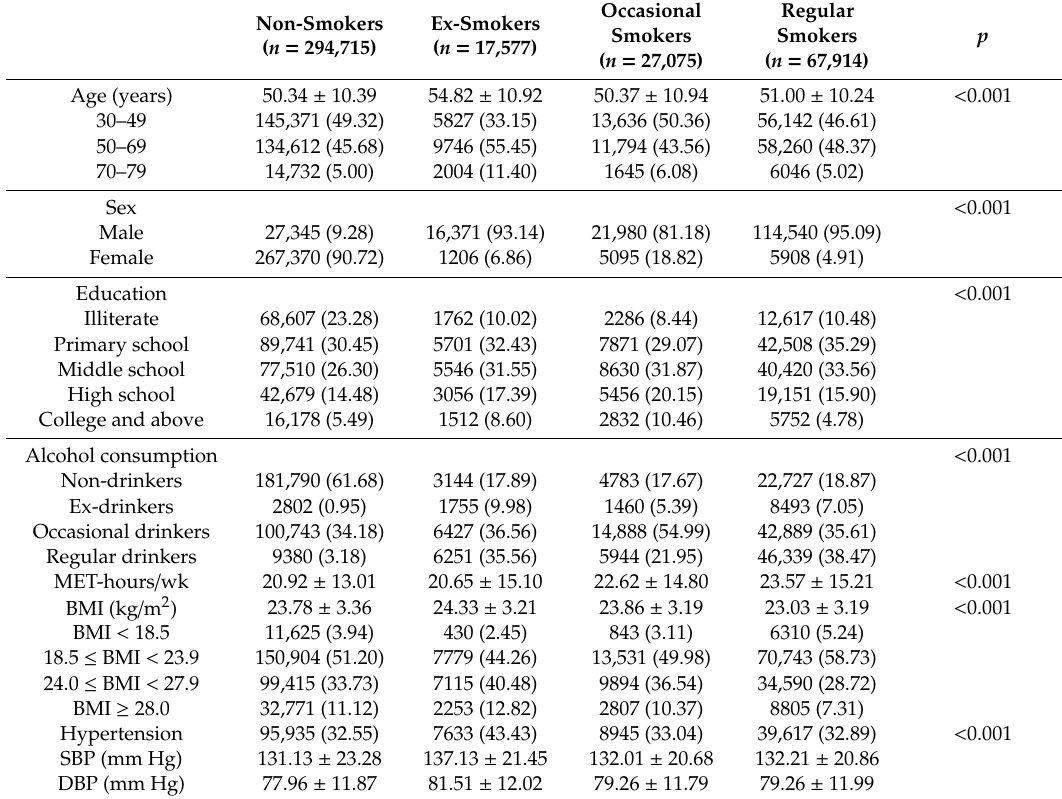
Table 1. Characteristics of the study populations by smoking